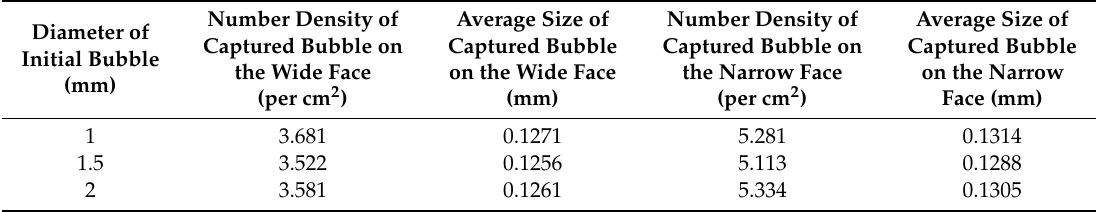
Table 3. Captured bubble distribution with di ff erent initial bubble sizes at the operation casting speed of 1.5 m / min and gas flow rate of 8.2% gas volume